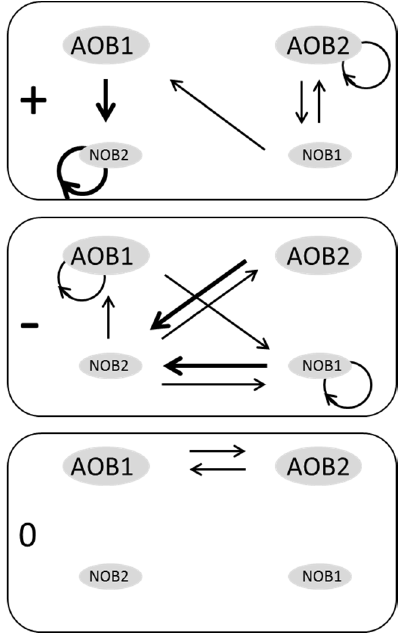
Figure 4. Interaction web (based on the statistical analysis of the signs of interactions). +, − and 0 correspond to positive, negative and neutral interactions, respectively. The size of bacteria “oval greys” and the thickness of lines indicate the trends of the bacterial abundances and the levels of interaction (based on the mean values reported in Table 3), respectively.